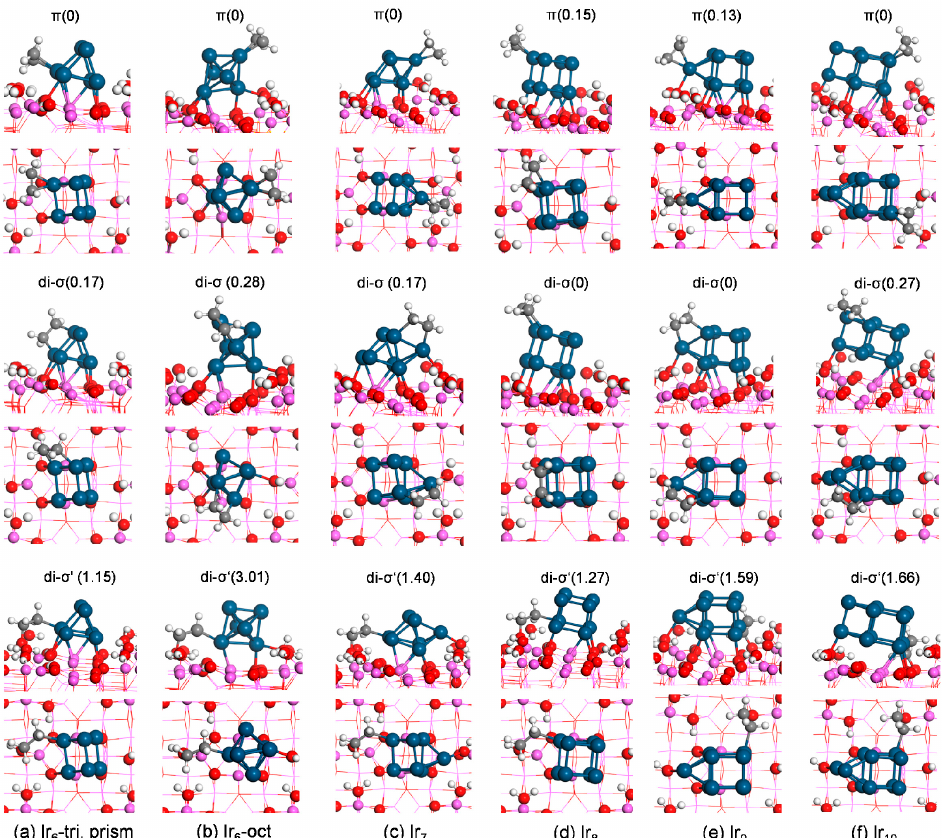
Figure 5. Side (top row) and top views (bottom row) of the most stable structure for each ethylene-binding mode on γ -Al 2 O 3 (110)-supported Ir n (n = 6–10). The energy difference (eV) with respect to the most stable configuration (energy set to 0) is labeled at the top of the figure. The color/label scheme is identical to Figure 4.